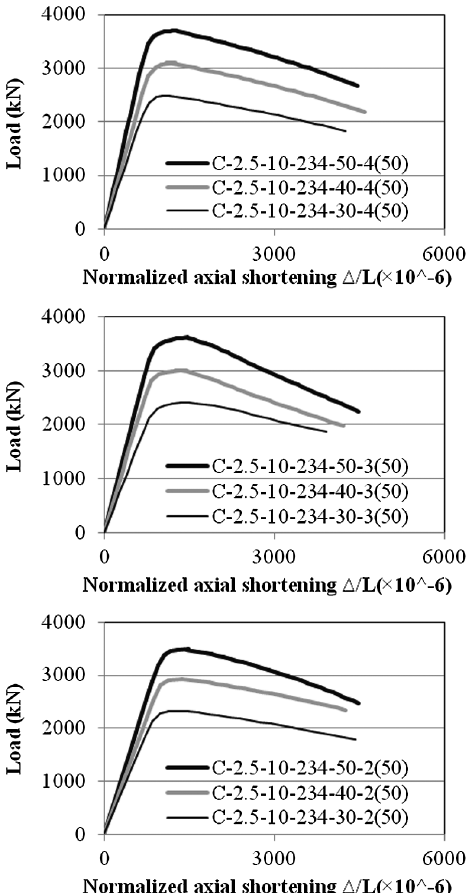
Fig. 16. Effect of steel yield stress on ultimate axial